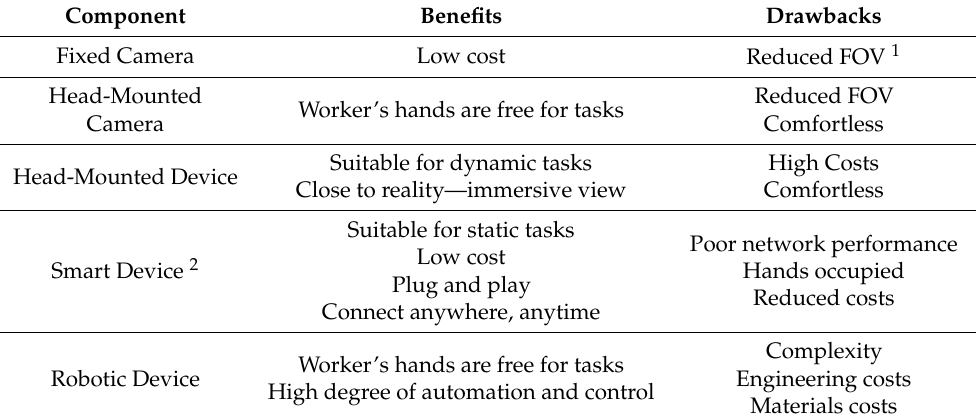
Table 5. Applications of remote collaboration